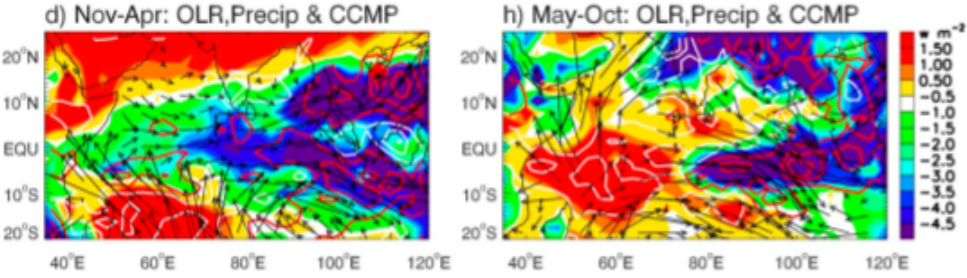
Figure 15. ( a ) The composite for the November–April mean, 8 year low-passed ORAS4 SLA (color contours), and the JRA55 surface wind stress (arrows; units: × 0.2 dyn cm − 2 ) for years 1998–2002 when the magnitudes of ORAS4 SLA of Reg. 1 (Figures 6–10) exceeded − 0.5 STD (see Figure 11a); it is the same as Figure 13a except for the years within 1993–2011 when all the datasets are available; linear trend for 1993–2011 is removed from each field; ( b ) same as ( a ) but with no lowpass filtering; ( c ) same as ( b ) but for the AVISO SLA and cross-calibrated multiplatform (CCMP) satellite winds with no filtering; ( d ) same as ( c ) but with color contours showing the Outgoing Longwave Radiation (OLR) anomaly (white (red) line contours showing the Global Precipitation Climatology Project (GPCP) negative (positive) precipitation anomaly, beginning at ± 0.2 mm day − 1 with an interval of 0.4; the zero contour suppressed); the OLR and precipitation anomalies are shown over both ocean and land; panels ( e – h ) are the same as ( a – d ) except for the May–October mean composites for years 1993 and 1999–2001 when the magnitudes of ORAS4 decadal SLA of Reg. 4 exceeded +0.5STD (see Figure